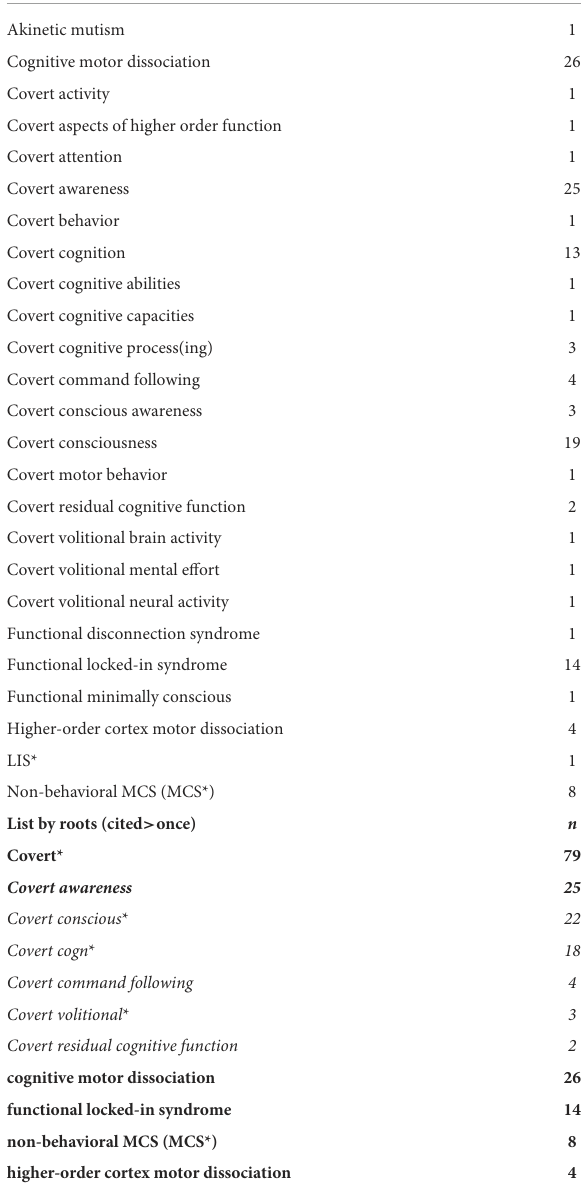
TABLE 1 List of names given to our target clinical entity since